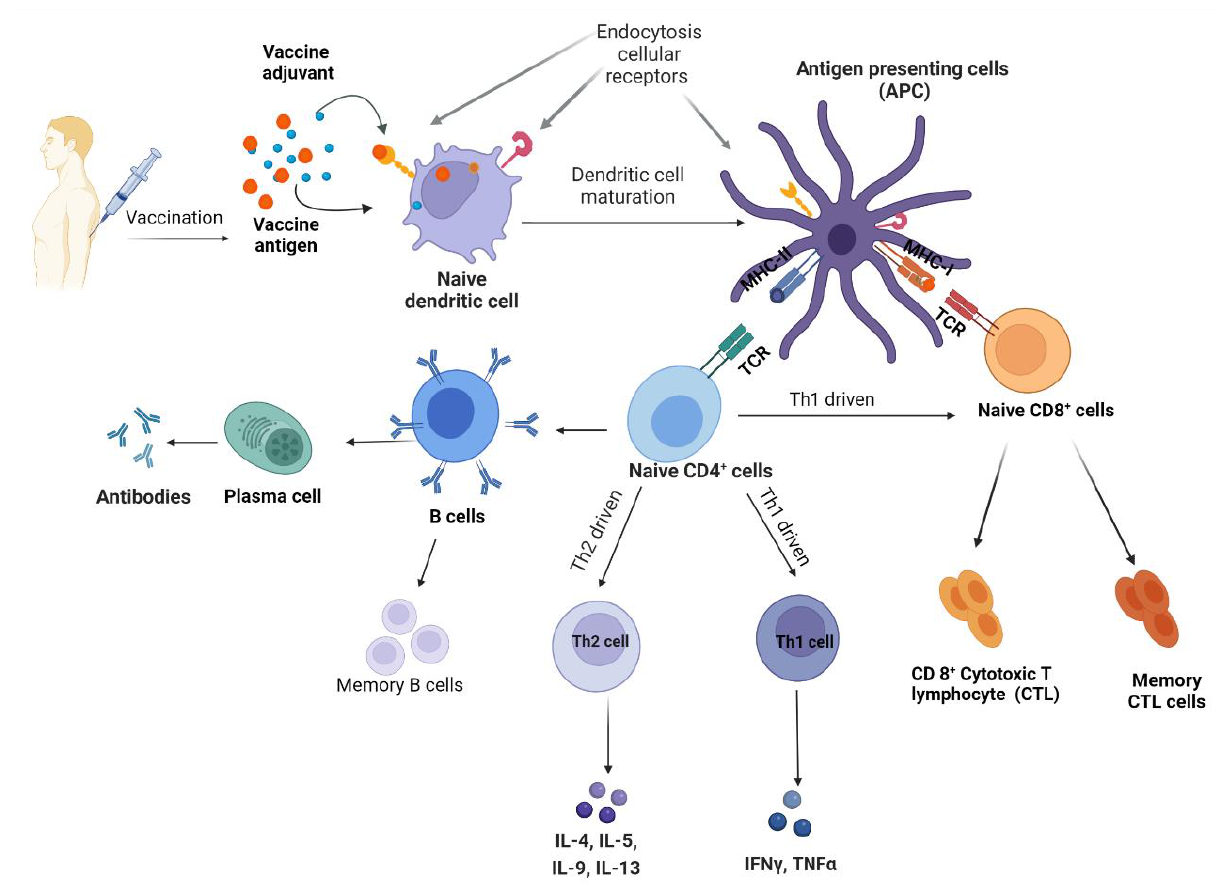
Figure 1. Schematic of an immune response following vaccination. In adaptive immunity, antigens combined with adjuvants are delivered to and bind with naïve dendritic cells, forming antigen- presenting cells (mature dendritic cells), which are recognized by major histocompatibility complex (MHC) class I and MHC-II, thereby binding with T-cell receptors on naïve CD8 + cells and naïve CD4 + T cells, respectively. Naïve CD4 + cells stimulate the production of Th1 (or Th2) responsible for the secretion of different cytokines, and induction of cellular and humoral immunity, respectively.